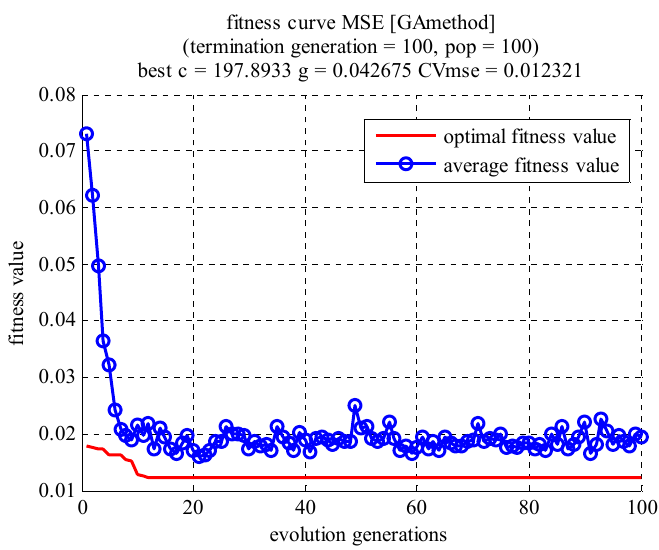
Figure 7. The fitness curve of chicken swarm optimization algorithm.